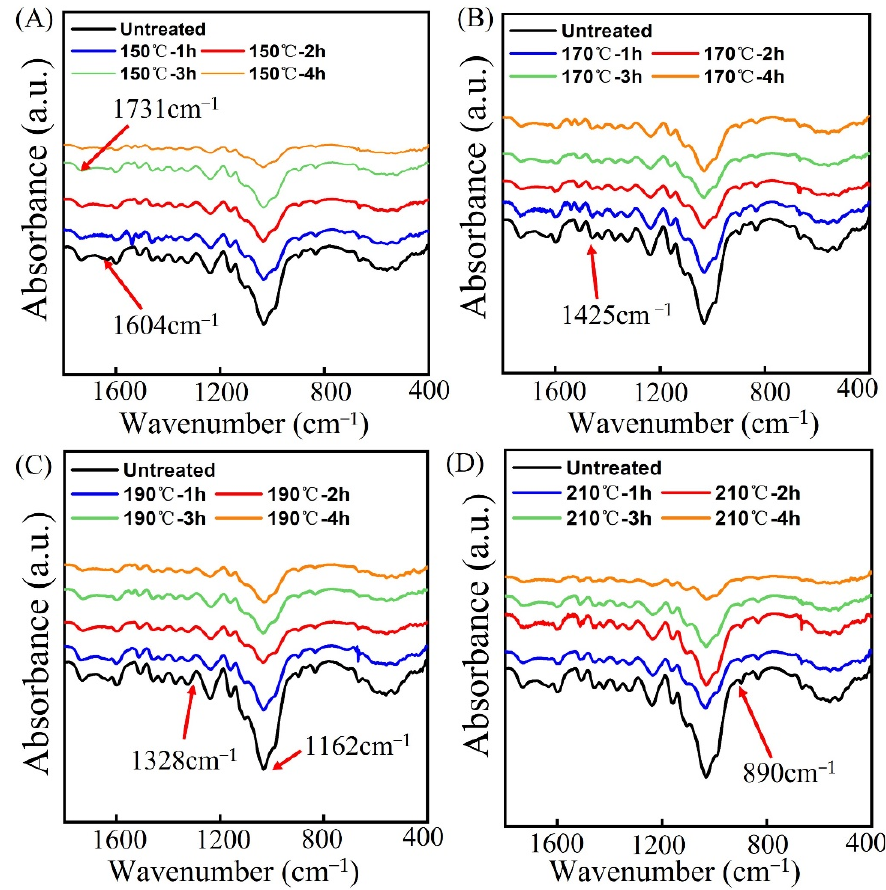
Figure 6. FTIR of treated bamboo samples after different temperatures and durations .